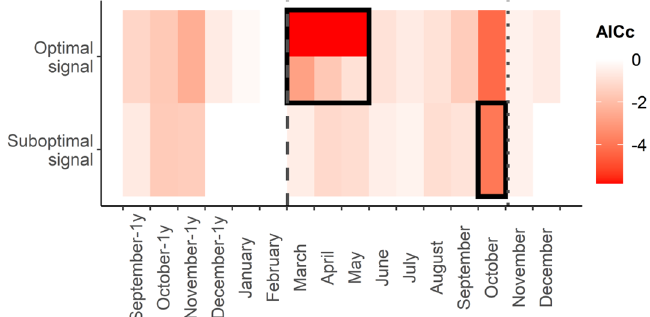
Figure 2. Results of the sliding window analysis indicating optimal and suboptimal signals of the temperature for the prediction of the autumn V. destructor abundance. Colour gradient indicate AIC c changes in relation to the baseline model (lower AIC c indicates a better model), black boxes show identified optimal and suboptimal signals, vertical grey lines indicate the multi-year average date of first spring cleansing flights (dashed) and last autumn flights (dotted). Notice that average March–May temperature obtained lower AIC c than averages from single months (AIC c for March–May temperature is indicated in the upper part of the rectangle that shows optimal signal).